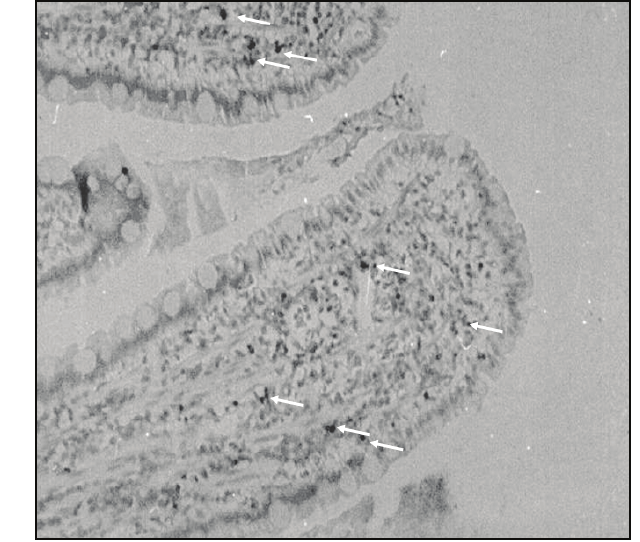
FIgURE 4 - Location of the TUNEL positive cells in the intestinal mucous membrane after 30-minute ischemia and 4-hour reperfusion. The arrow shows a TUNEL positive cell (Apoptag Kit, original magnification: